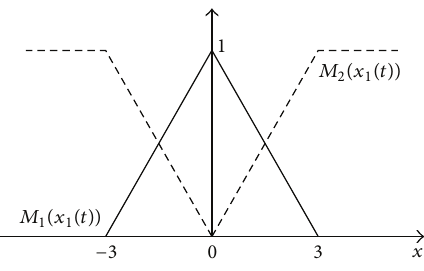
Figure 2: Fuzzy membership functions.